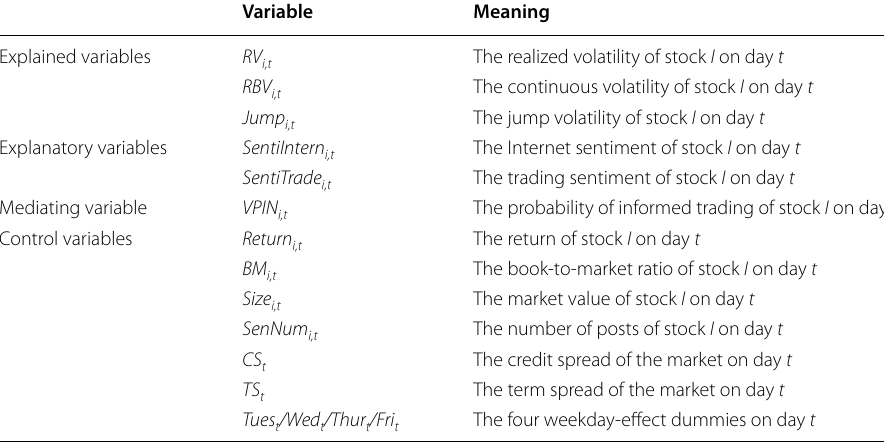
Table 1 Variable